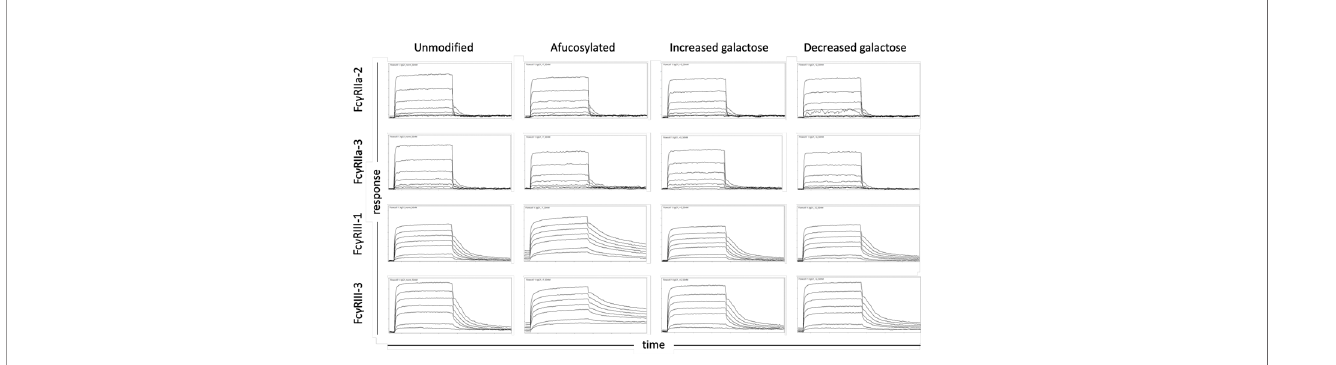
FIGURE 1 | Exemplary sensor data of Fc g R-IgG interactions. Sensorgams depicting the association and dissociation of Fc g R from IgG over time for prevalent Fc g RII (2 and 3) and Fc g RIII (1 and 3) allotypes (rows) and differentially glycosylated IgG (columns). The equilibrium dissociation constants reported in this work were calculated using the response measured at the end of the association phase when interactions had achieved steady state. Each receptor was evaluated over a three order of magnitude concentration range.